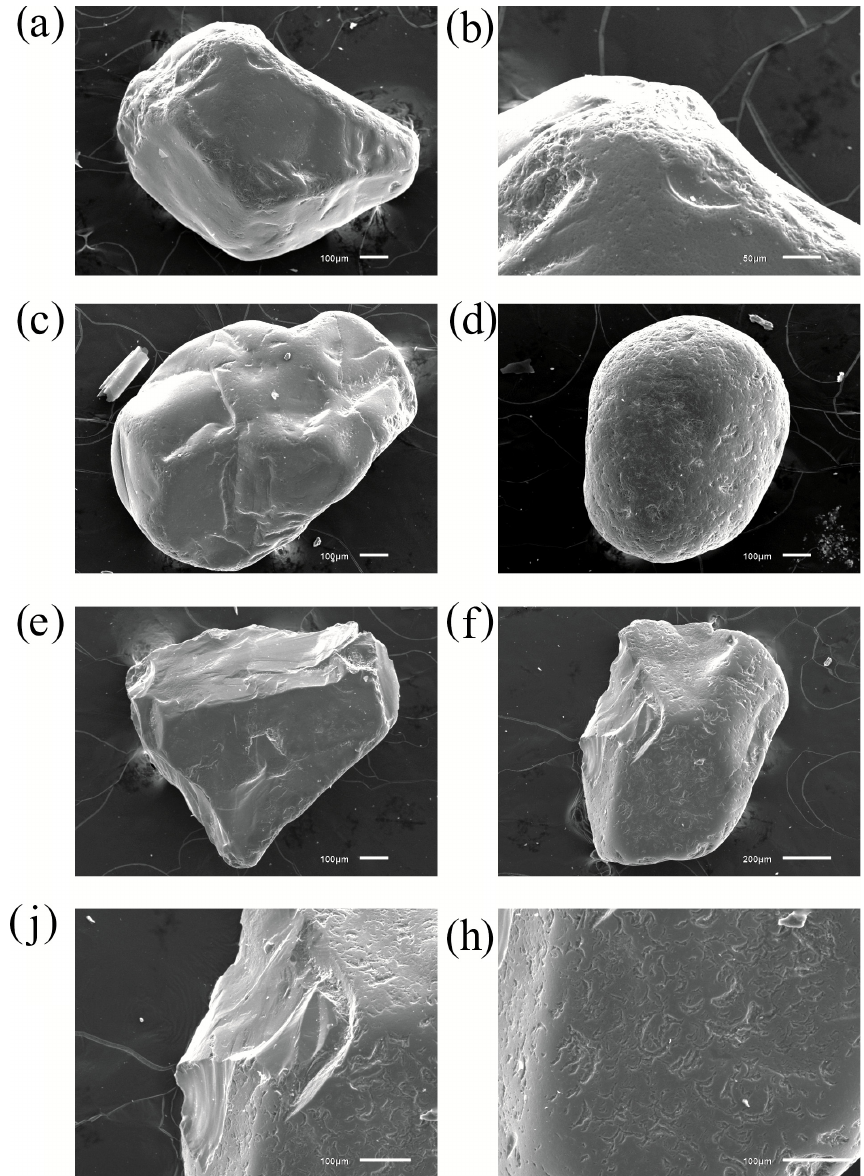
Figure A7. SEM photos of quartz grains from S7 section K-1: (a) glossy grain with a smooth surface and flat faces; the faces feature crescentic pits; grain tops feature fine pits; (b) fine-pitted surface of grain “a”; (c) glossy grain with a smooth surface and sparse fine pits; (d) half-matte grain with fine-pitted surface and crescent pits; (e) glossy grain with flat faces and no evident texture; (f) glossy grain with post-sedimentation conchoidal fractures and crescentic pits; (j) conchoidal fracture of grain “e”; (h) crescentic texture of grain